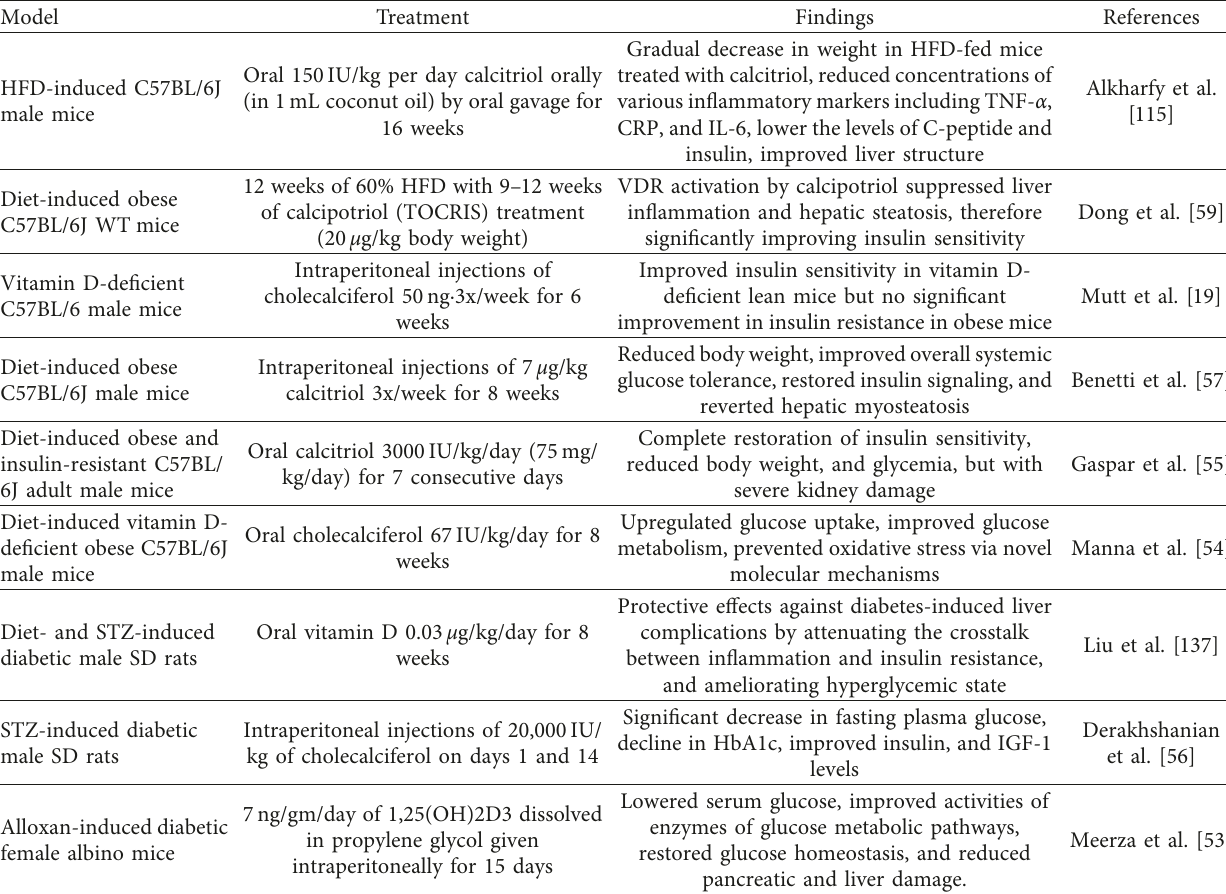
Table 1: Animal experimental studies on the effects of vitamin D on insulin resistance.